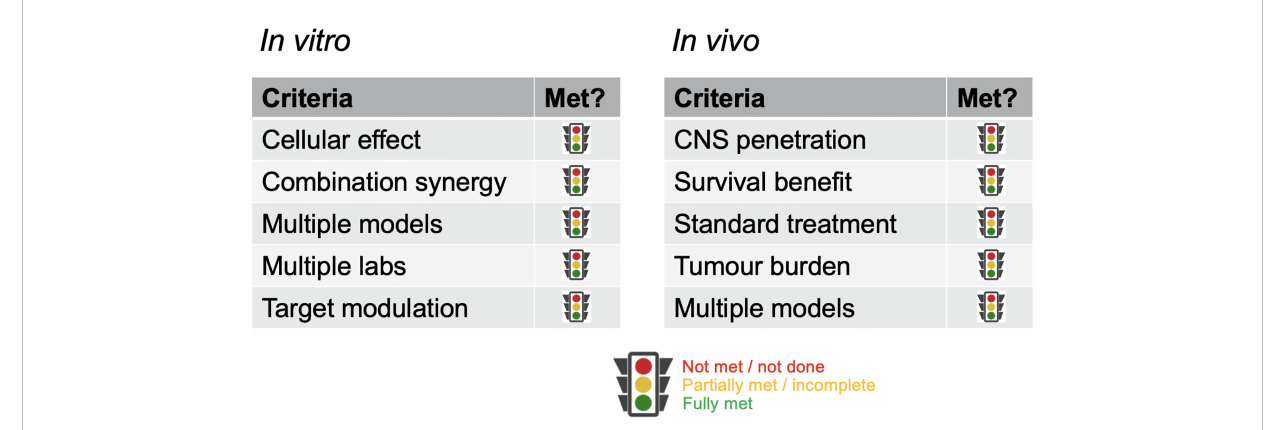
FIGURE 1 Criteria for critical review. Key parameters against which data packages should be assessed. Rather than a metrics-based scoring system, a fully justi fi ed benchmarking against each category should be